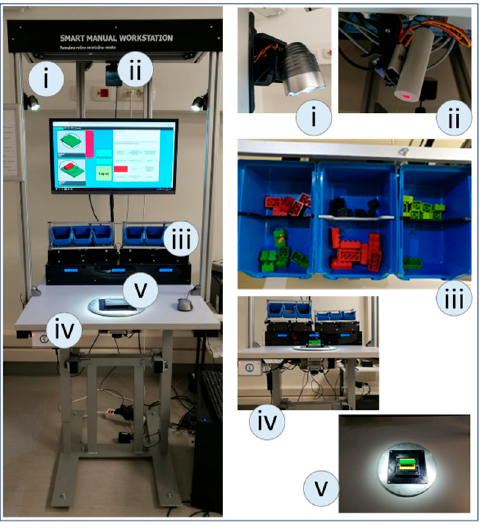
Figure 1. Smart manual assembly workstation with implemented tools.